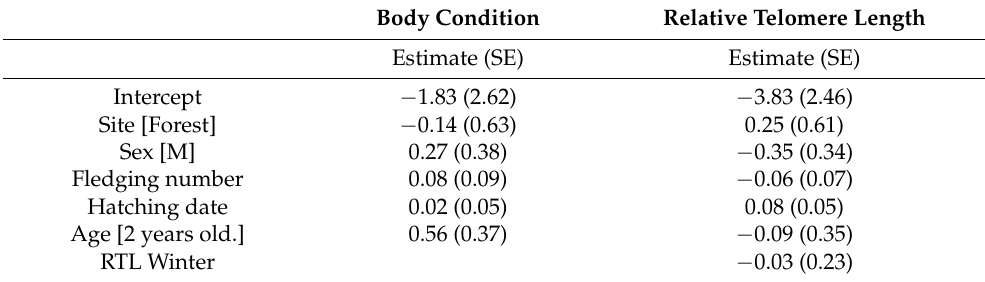
Table A5. Change of body condition and telomere length with reproduction for re-caught